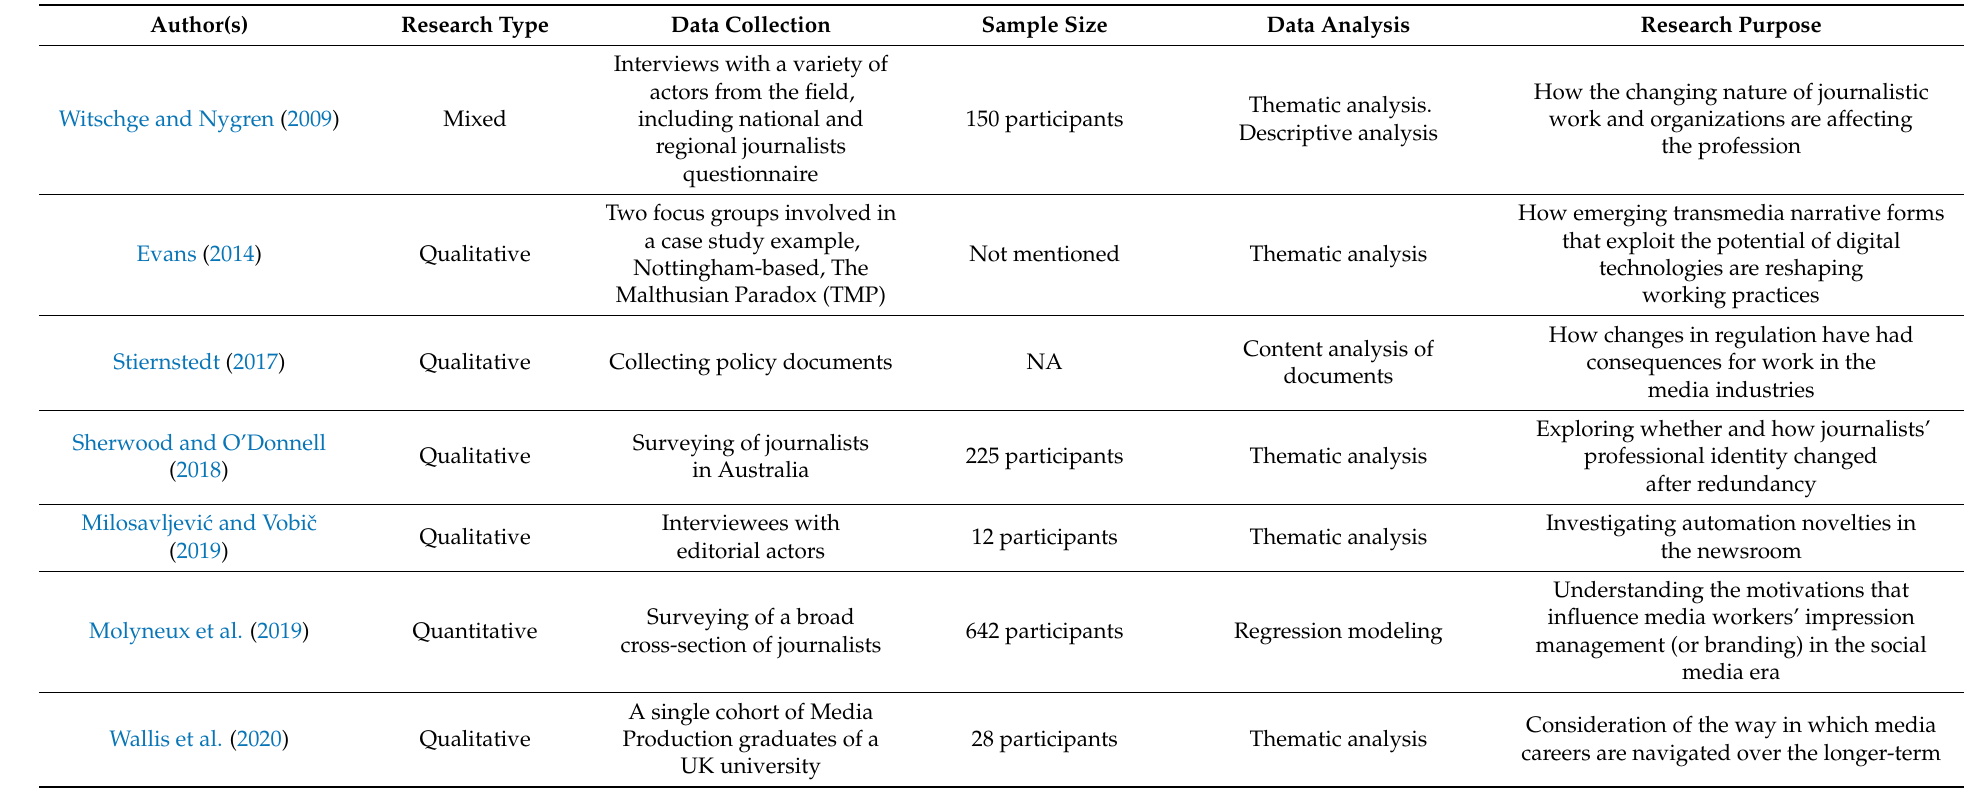
Table 8. Distribution of papers in the subtheme “influencing